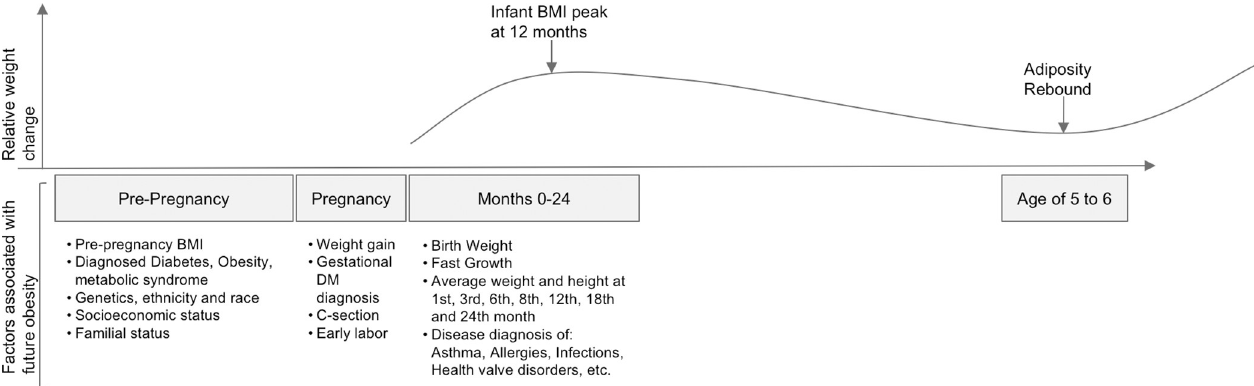
Fig 1. Factors at the prenatal and infancy periods associated with early childhood obesity by age five. Adapted from Gonza´lez-Muniesa et al. [21].